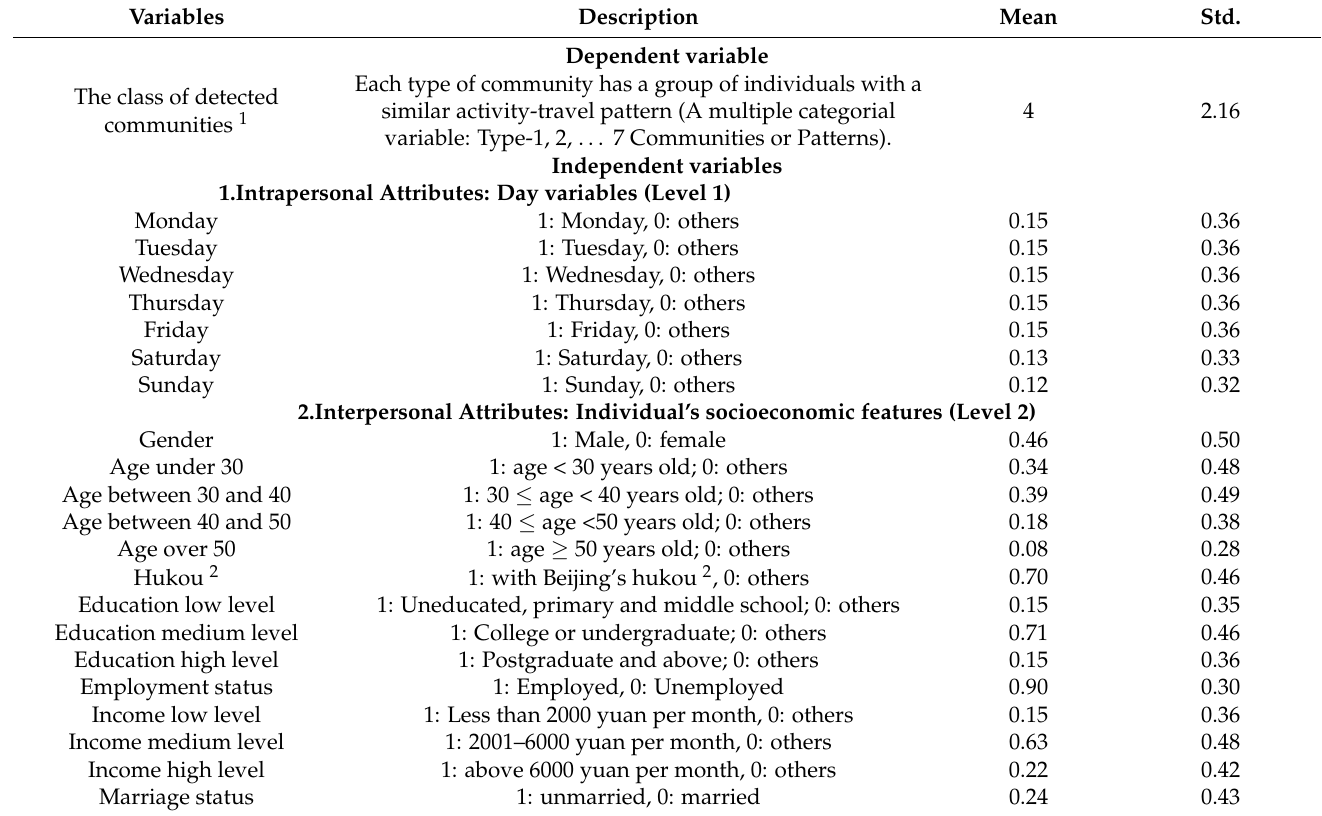
Table 1. Description of the variables of intrapersonal and interpersonal variabilities in daily activity-travel patterns. Variables Description Mean Std. Dependent variable The class of detected communities